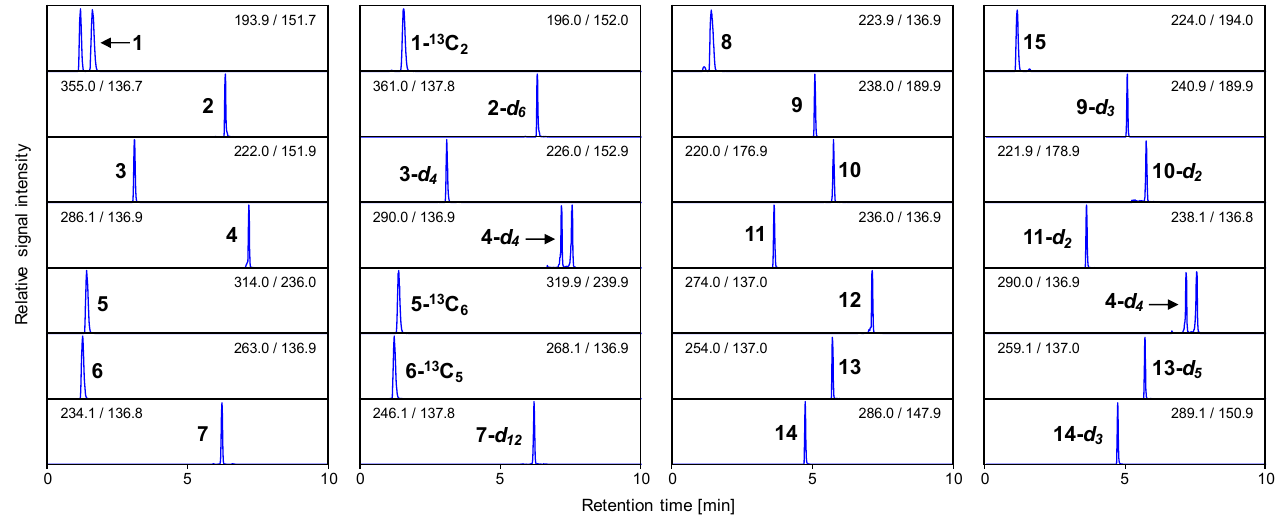
16 of 21 Figure 3. The derivatization of aldehydes, ketones ( a ), and organic acids ( b ) with 3- nitrophenylhydrazine (3-NPH) using N -(3-(dimethylamino)propyl)- N ′ -ethylcarbodiimide (EDC) as a coupling reagent and pyridine as a catalyst: 2,3-butanedione ( 2 ), ( E,E )-2,4-decadienal ( 4 ), D-fructose ( 5 ), hexanal ( 7 ), methional ( 9 ), 3-methylbutanal ( 10 ), ( E )-2-nonenal ( 12 ), phenylacetaldehyde ( 13 ), vanillin ( 14 ), acetic acid ( 1 ), butyric acid ( 3 ), lactic acid ( 8 ), and 3-methylbutyric acid ( 11 ). The carbonyl groups of aldehydes as well as ketones are colored blue and the carbonyl groups of organic acids are colored light brown. The presence of acetic acid, 2,3-butanedione, butyric acid, ( E,E )-2,4-decadienal, D-fructose, L-glutamic acid, hexanal, lactic acid, methional, 3-methylbutanal, 3-methylbutyric acid, ( E )-2-nonenal, phenylacetaldehyde, and vanillin was confirmed in bread crumb by comparison of LC retention times and MS/MS spectra. The separation of the analytes was conducted in a single run within 10 min. Quantitation was performed with SIDA using acetic acid- 13 C 2 , 2,3-butanedione- d 6 , butyric acid- d 4 , ( E,E )-2,4-decadienal- d 4 , D-fructose- 13 C 6 , L-glutamic acid- 13 C 5 , hexanal- d 12 , 3-hydroxypropionic acid, methional- d 3 , 3-methylbutanal- d 2 , 3-methylbutyric acid- d 2 , phenylacetaldehyde- d 5 , and vanillin- d 3 as corresponding internal standards, which were spiked to the bread crumb prior to sample